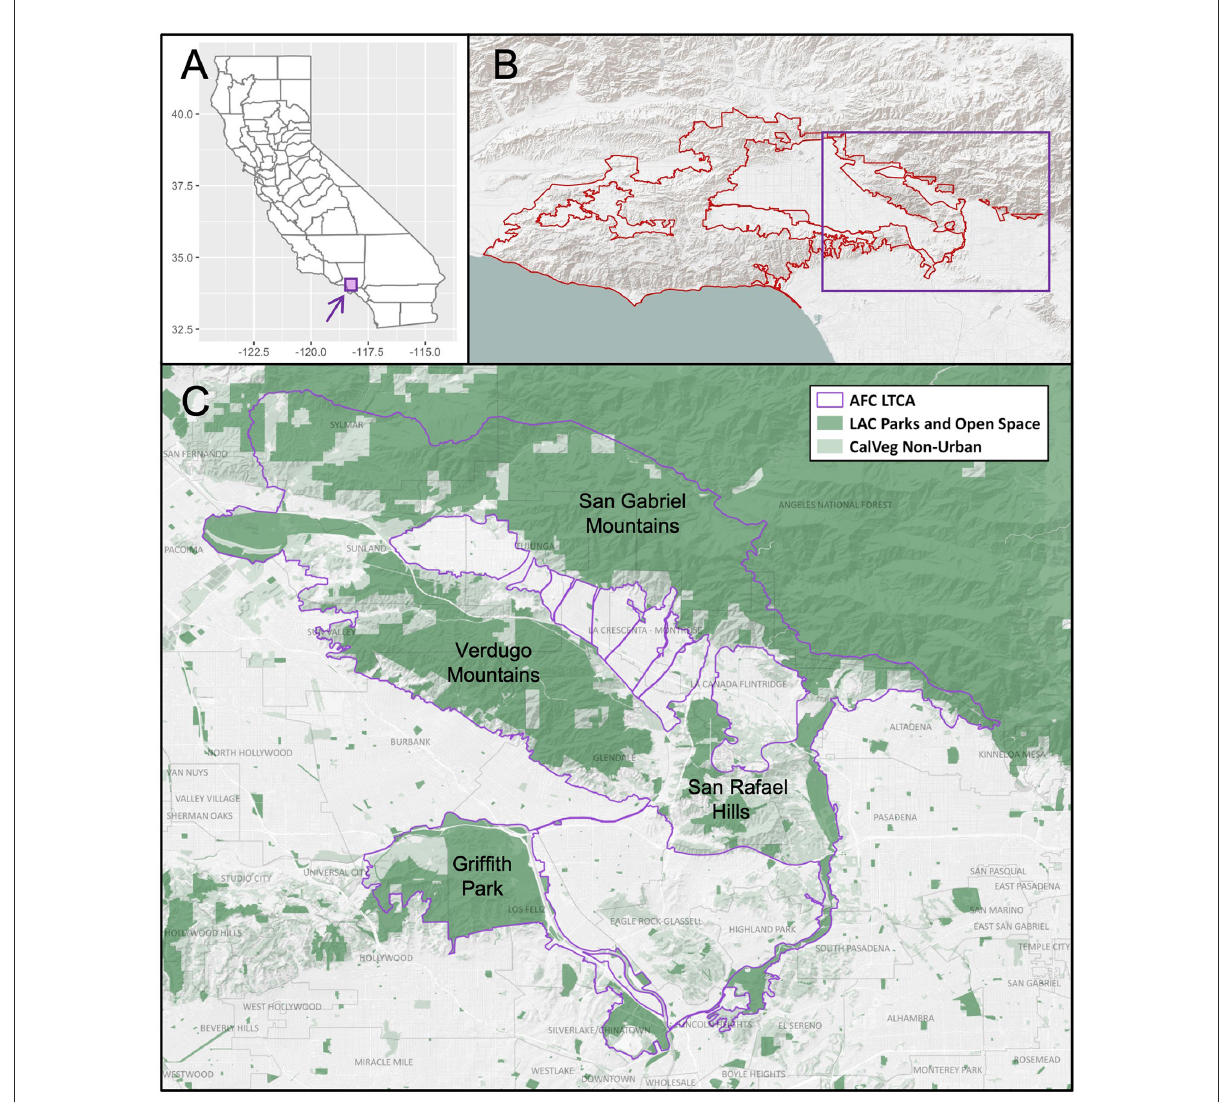
FIGURE2 Map of the Arroyos & Foothills Conservancy’s Long Term Conservation Area (AFC LTCA) on the eastern edge of the Rim of the Valley Corridor, a case study of an urban wildlife corridor. (A) Location of the study area (purple box) within California. (B) Location of the study area (purple box) in reference to the Rim of the Valley Corridor (red outline). (C) Extent of the LTCA in the Greater Los Angeles area (purple outline). Existing public parks and open space (LA County) are shown in dark green. Remaining land is classified into urban (white) and non-urban (light green; CalVeg). Key areas of protected open space needing connection include the Verdugo Mountains, San Gabriel Mountains, the San Rafael Hills, and Griffith